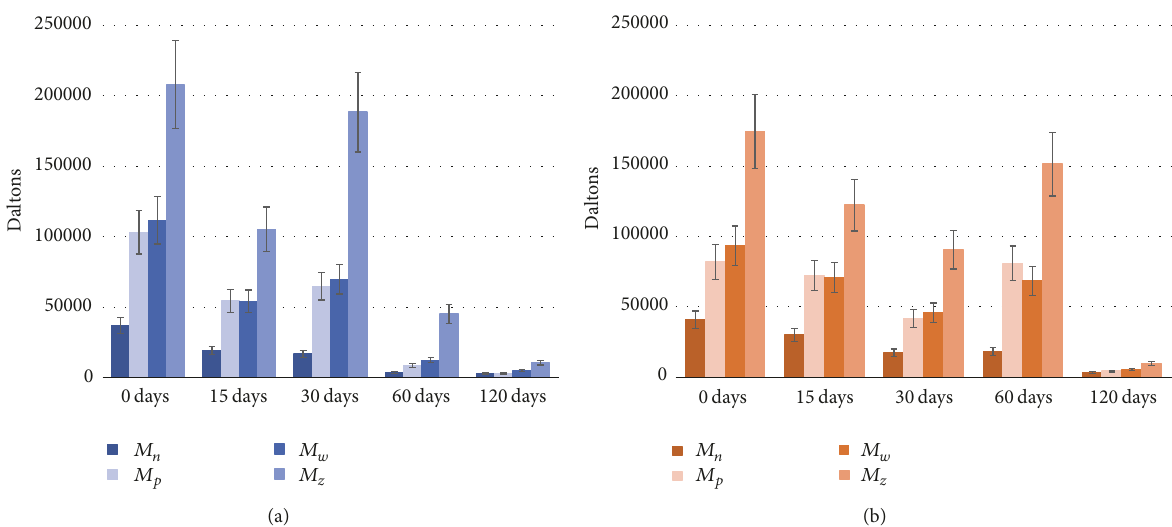
Figure 5: Molar mass (mean ± deviation) of the PLGA plates in the 0, 15, 30, 60, and 120 days of degradation in PBS solution for PLGA low T (a) and PLGA high T